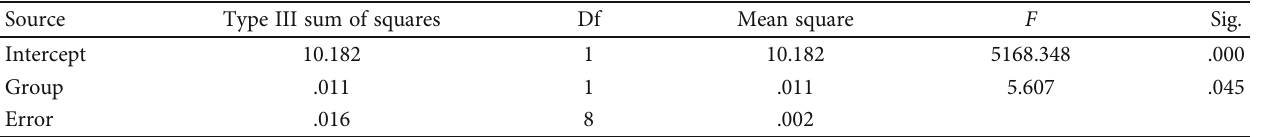
Table 4: One-way analysis of variance test results for between-group